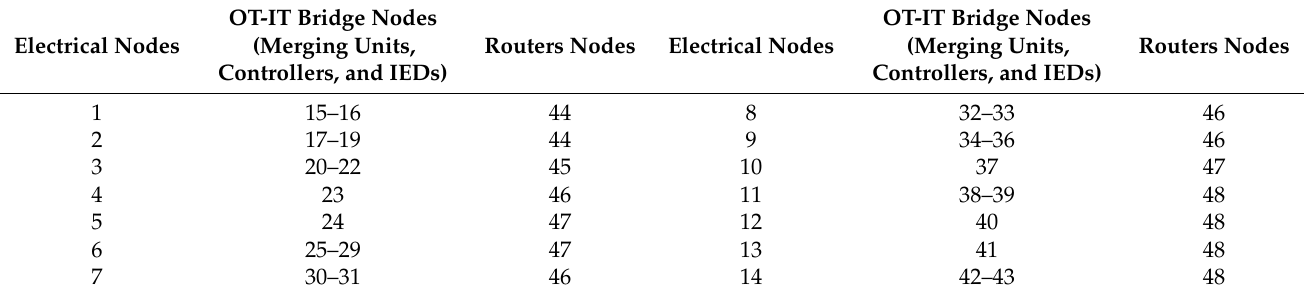
Table 2. Node connection in the OT (power)-IT (ICT) smart grid for the IEEE 14-bus test case.